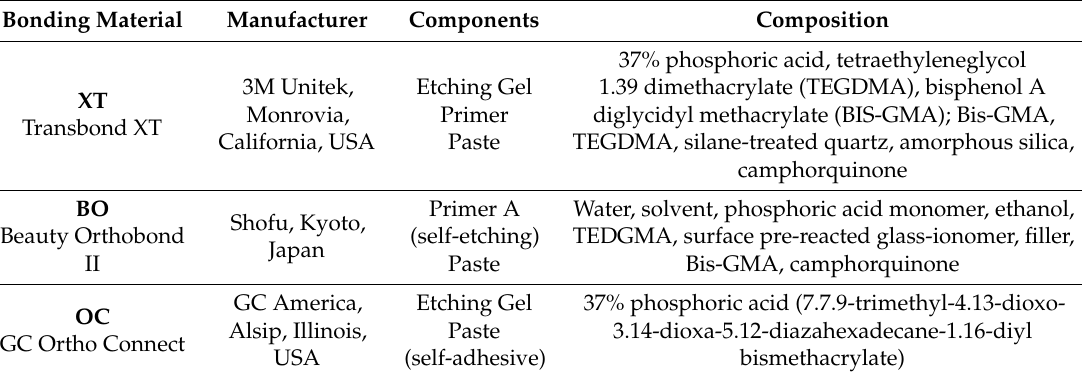
Table 1. Composition of tested adhesive systems.